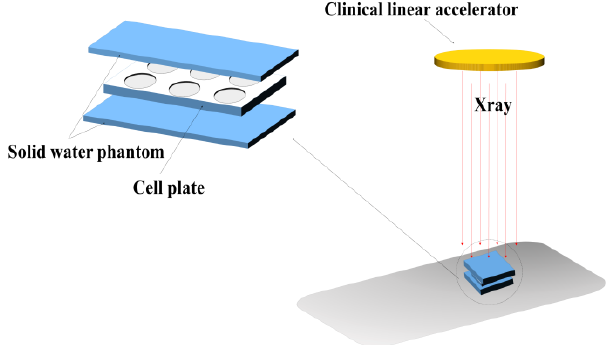
Scheme 1. In vitro radiation experiment